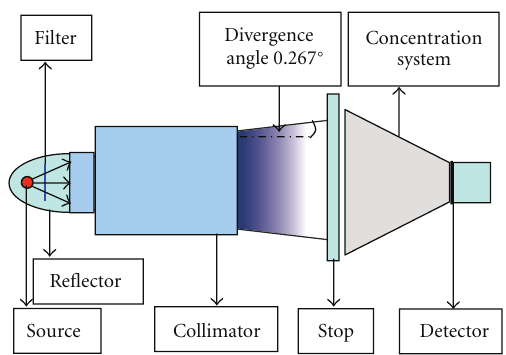
Figure 1: Schematic diagram of concentration test system.